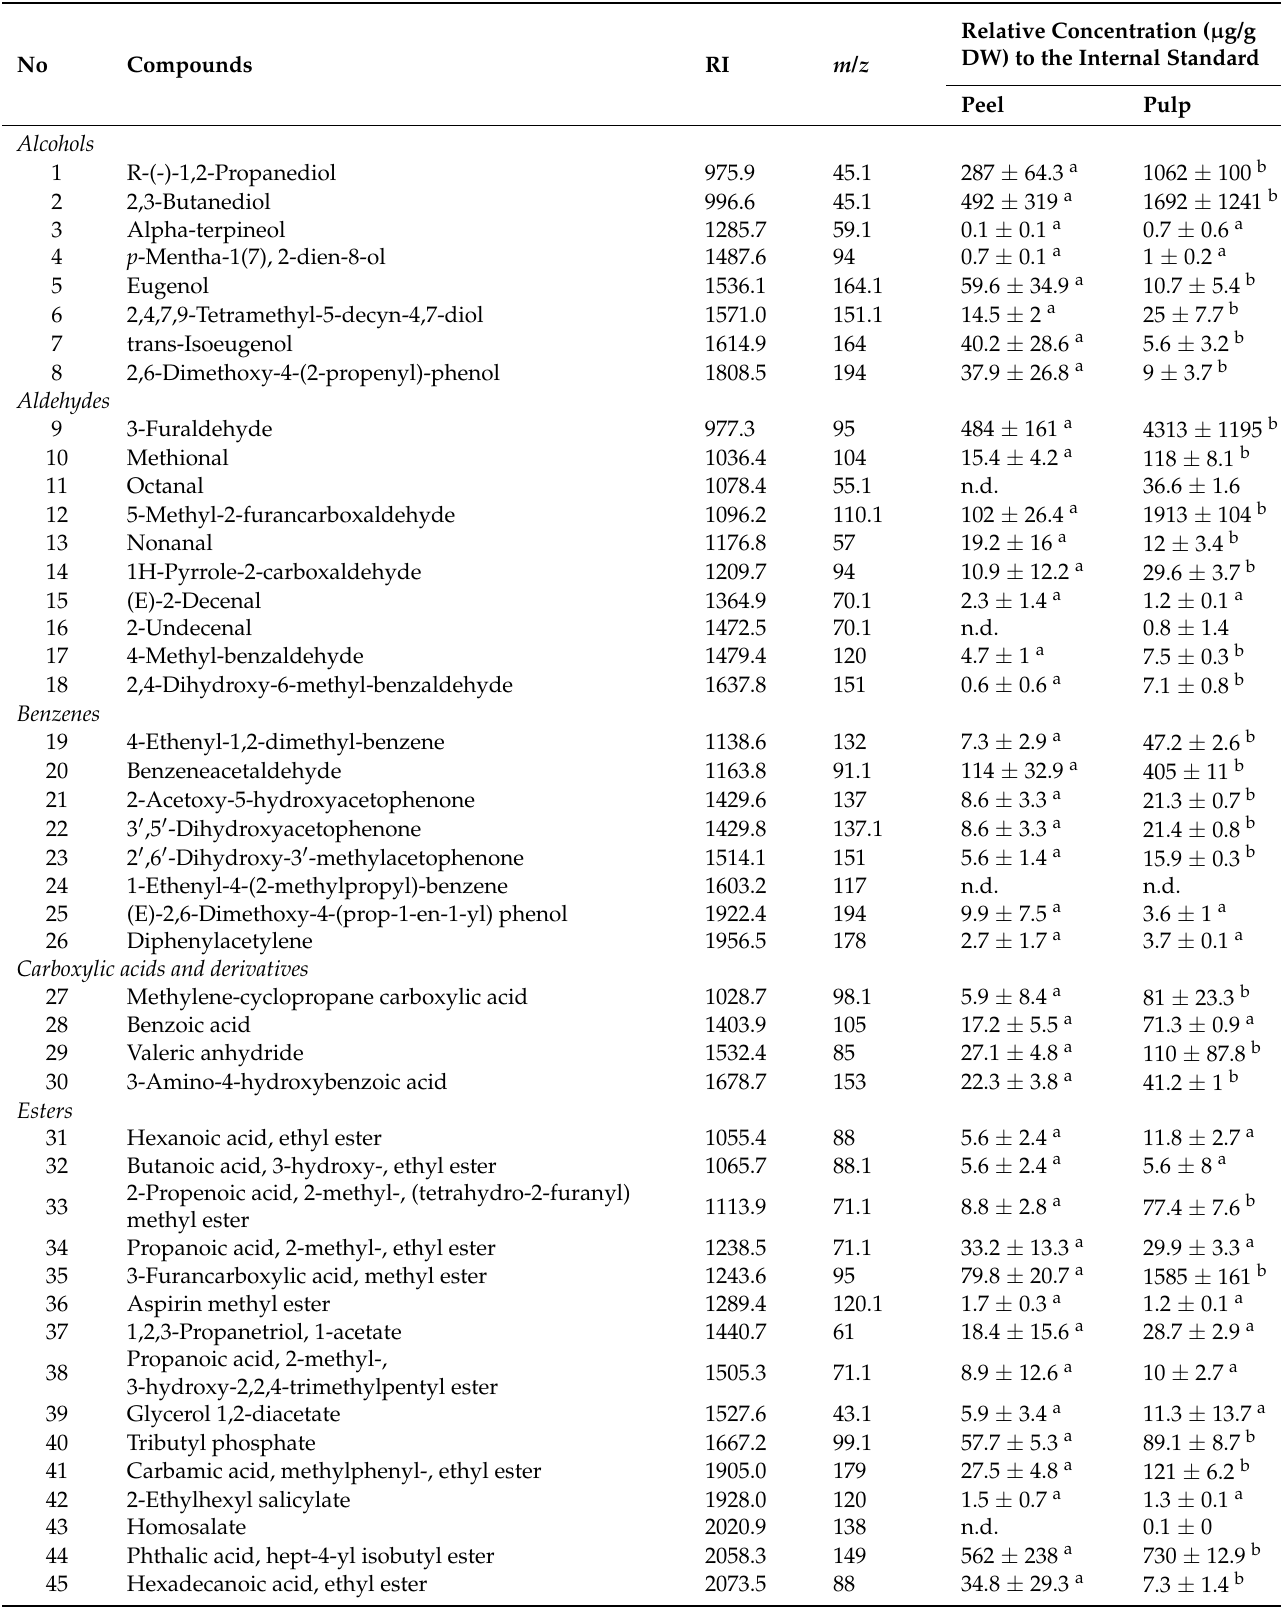
Table 2. Volatile compounds and their relative contents in peel and pulp of freeze-dried tamarillo are presented as mean ± SD ( n = 3) and listed in the order of chemical groups and then retention index. Letters (a, b) indicate statistical difference ( P < 0.05) across each